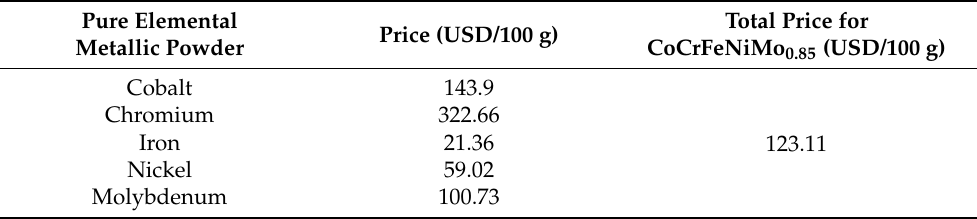
Table 2. Costs for elemental metallic powder materials purchased from Laboratorium ® .